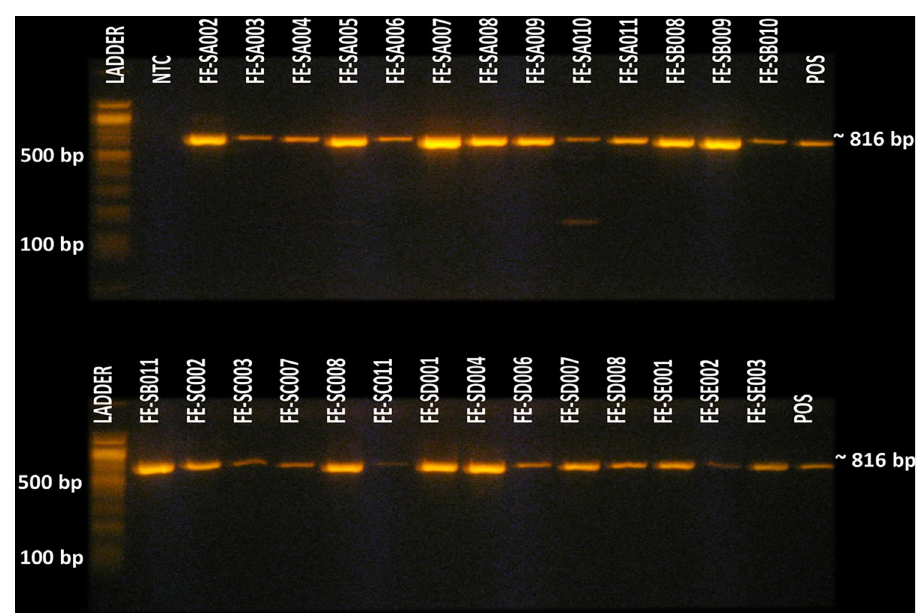
Fig 2. Detection of Campylobacter sp. in rhesus macaque fecal samples using PCR.